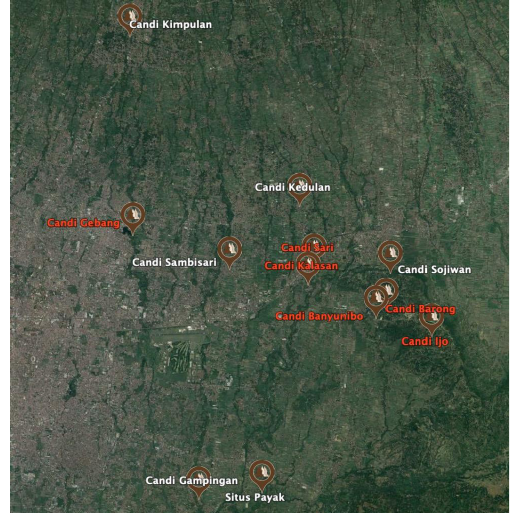
Figure 3. Overview of the sites surveyed during the campaign